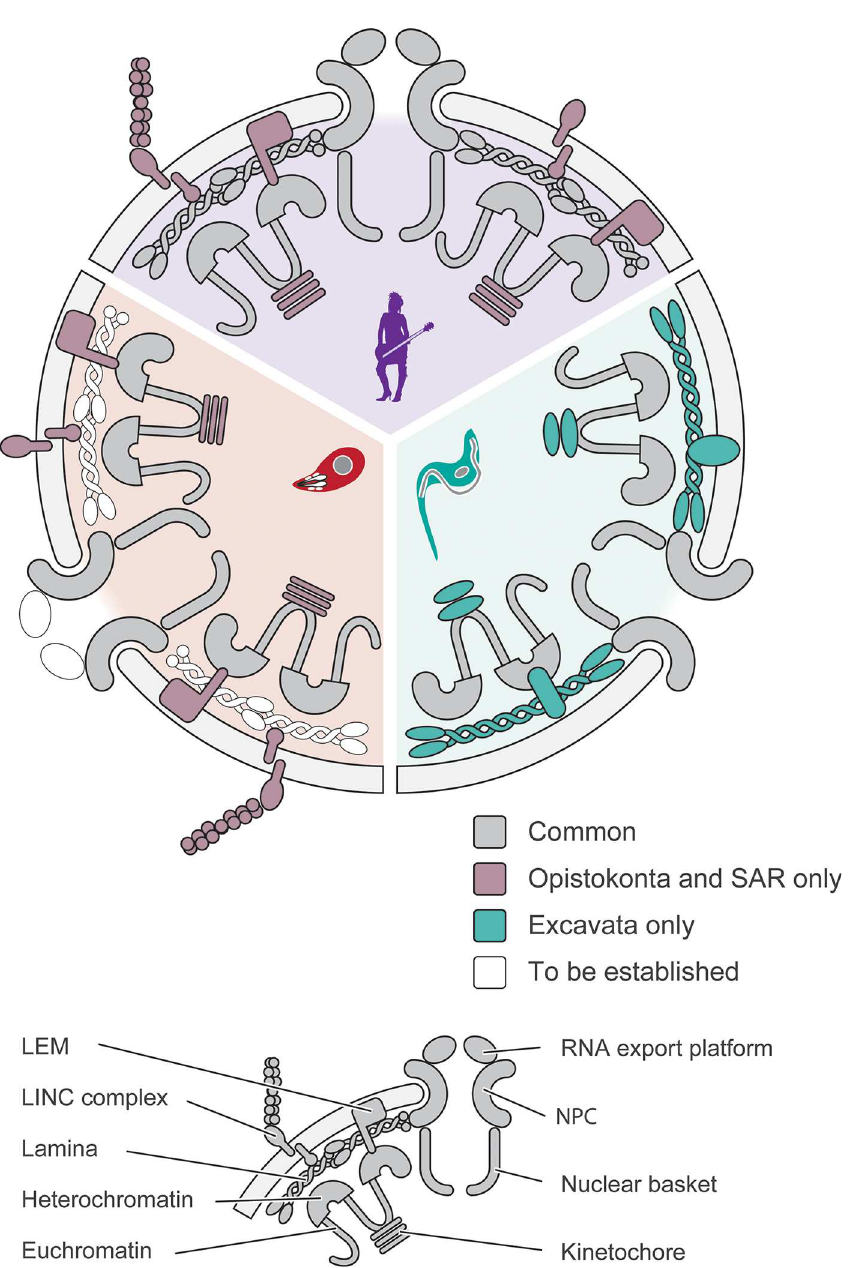
Fig 2. Conservation and divergence atthe nuclearenvelope. The majorproteinandnucleicacidcomplexes responsiblefor controlof geneexpression, nucleocytoplasmictransport,andregulationof nucleararchitectureare shown.The circularnucleusdiagramis dividedintothreecolourised sectorsthat correspondto thoseof Fig 1. Elements arecolourisedthat areknownto deviatefrom likelyLECAcomponents, whilstunknownelements are shownas opensymbols. Mixedpurple/greenis usedto designatefactorsthat aresharedbetweenOpisthokonts andApicomplexa.Significantly, theextensivelystudied Homosapiens nucleusappearsto retainmuchof